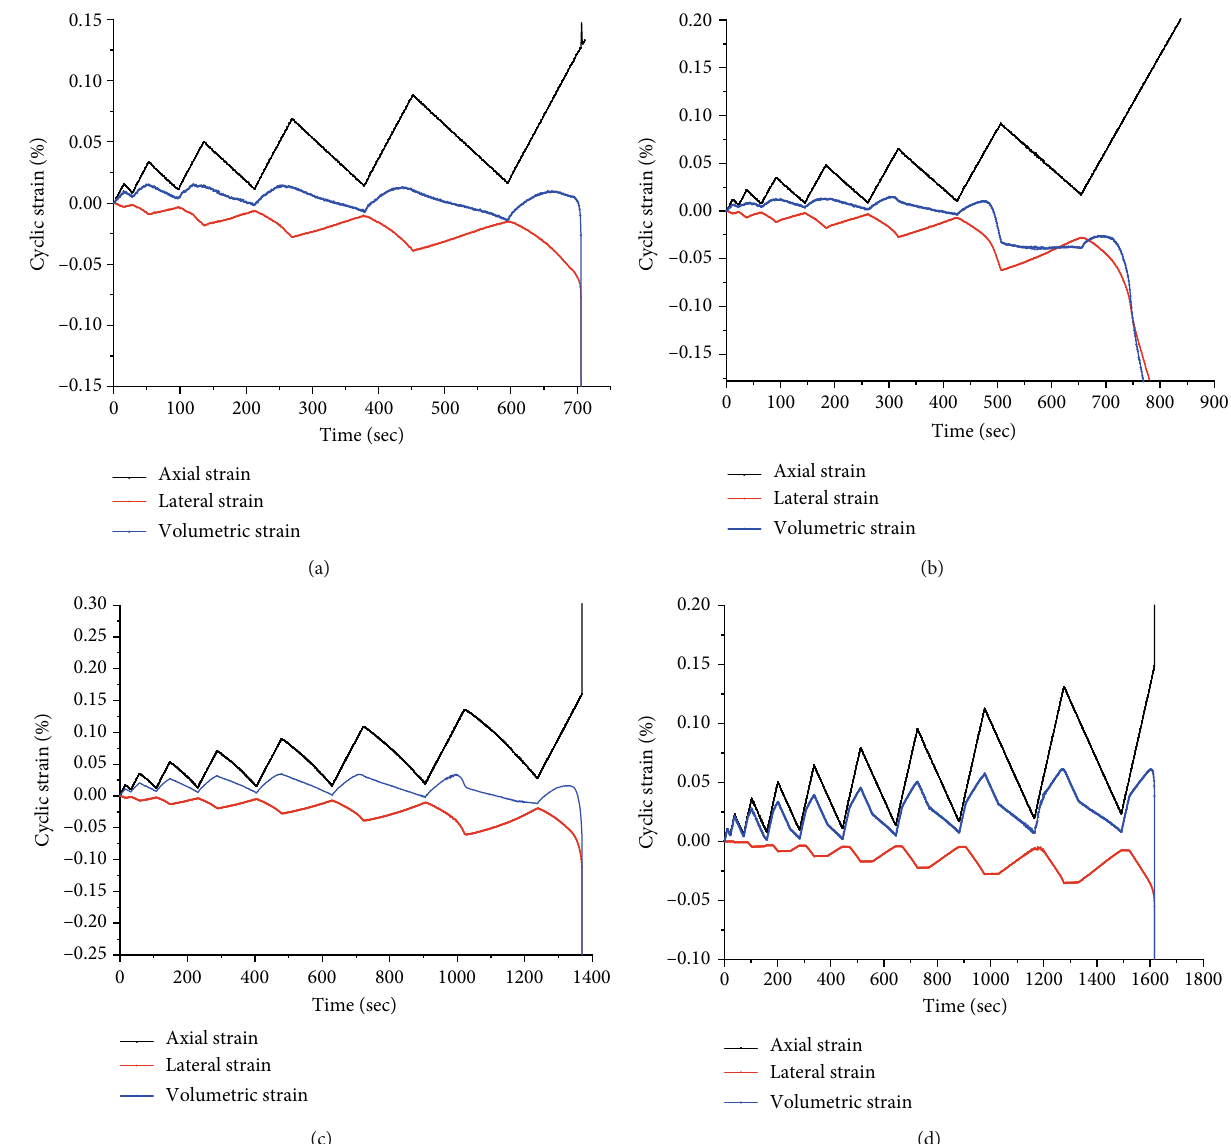
Figure 10: Plots of the (a) AE accumulative counts and the (b) AE accumulative energy against the freeze-thaw